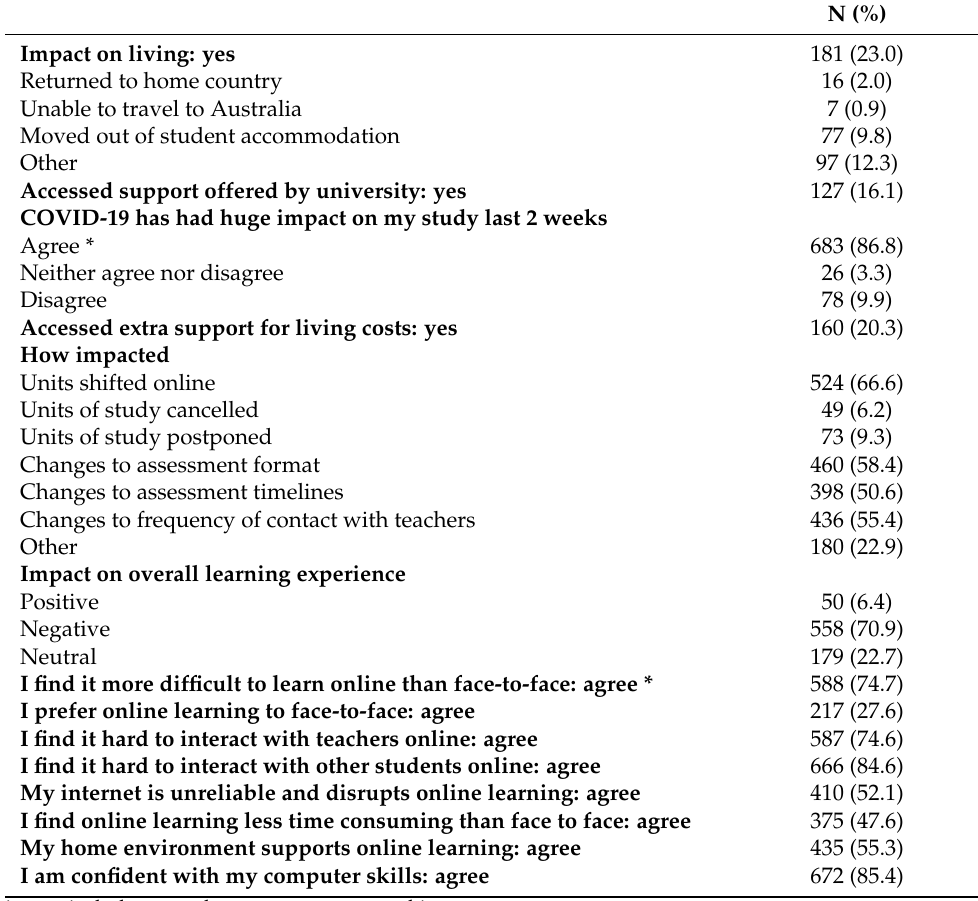
Table 3. Impact of COVID-19 on living and study (N =